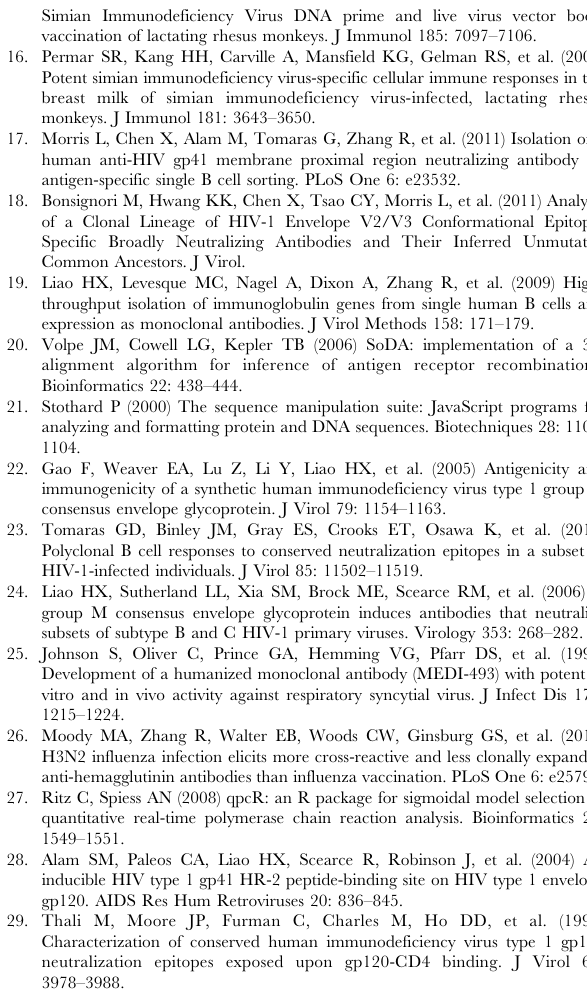
Table S1 MAbs CH07 and CH08 heavy and light chain and CDR3